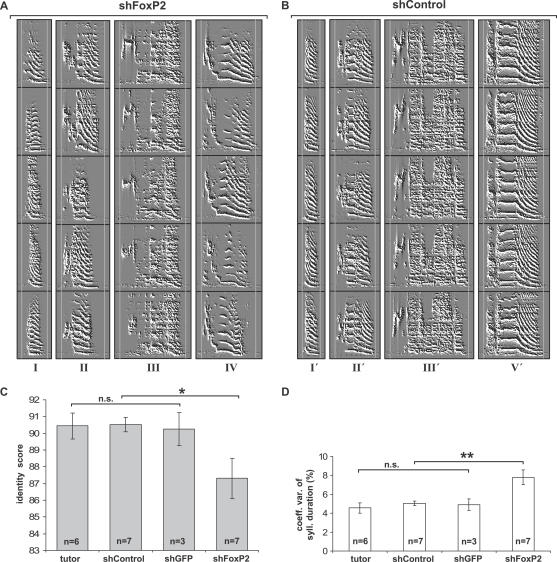
Variability of Syllable Production in FoxP2 Knockdown PupilsEach vertical column shows the sonograms of five different renditions of the same syllable (scale bar indicates 100 ms, frequency range = 0–8,600 Hz). Each syllable, labeled by a roman numeral, was selected from a different bird. Of note, the first three syllables in (A) (syllables I, II, and III) were imitated from the same tutor as the corresponding syllables in (B) (syllables I′, II′, and III′).(A) FoxP2 knockdown pupils. Two vertical lines mark the beginning and the end of the longest rendition of each syllable to visualize variability of syllable duration (particularly evident in syllables II and IV). Also note the variability in acoustic structure between different renditions of the same syllable (e.g., FM of syllable I, shape and frequency of first element of syllable III, and PG of last element of syllable IV).(B) Syllable duration is relatively invariant in control pupils, as indicated by the vertical lines marking the beginning and the end of each syllable. Acoustic structure is also stable across syllable renditions.(C) Acoustic variability of syllables from rendition to rendition was higher in shFoxP2-injected than in control pupils (shGFP and shControl injections), as indicated by significantly lower syllable identify scores (two-tailed Mann-Whitney U test, *p < 0.05; Bonferroni-corrected α-level). Control and tutor birds sang with comparable variability (two-tailed Mann-Whitney U test, p > 0.8; tutors n = 6, on average 5 syllables per animal; shControl n = 7 animals, on average 4 syllables per animal; shGFP n = 3, on average 5 syllables per animal).(D) Syllable duration varied more from rendition to rendition in knockdown pupils (shFoxP2) than in controls (shControl and shGFP) and tutors, as indicated by a higher mean coefficient of variation of syllable duration (±SEM, two-tailed Mann-Whitney U test, **p < 0.001; Bonferroni-corrected α-level; no difference between tutors, shControl-injected, and shGFP-injected animals, p > 0.7, same animals as [C]).